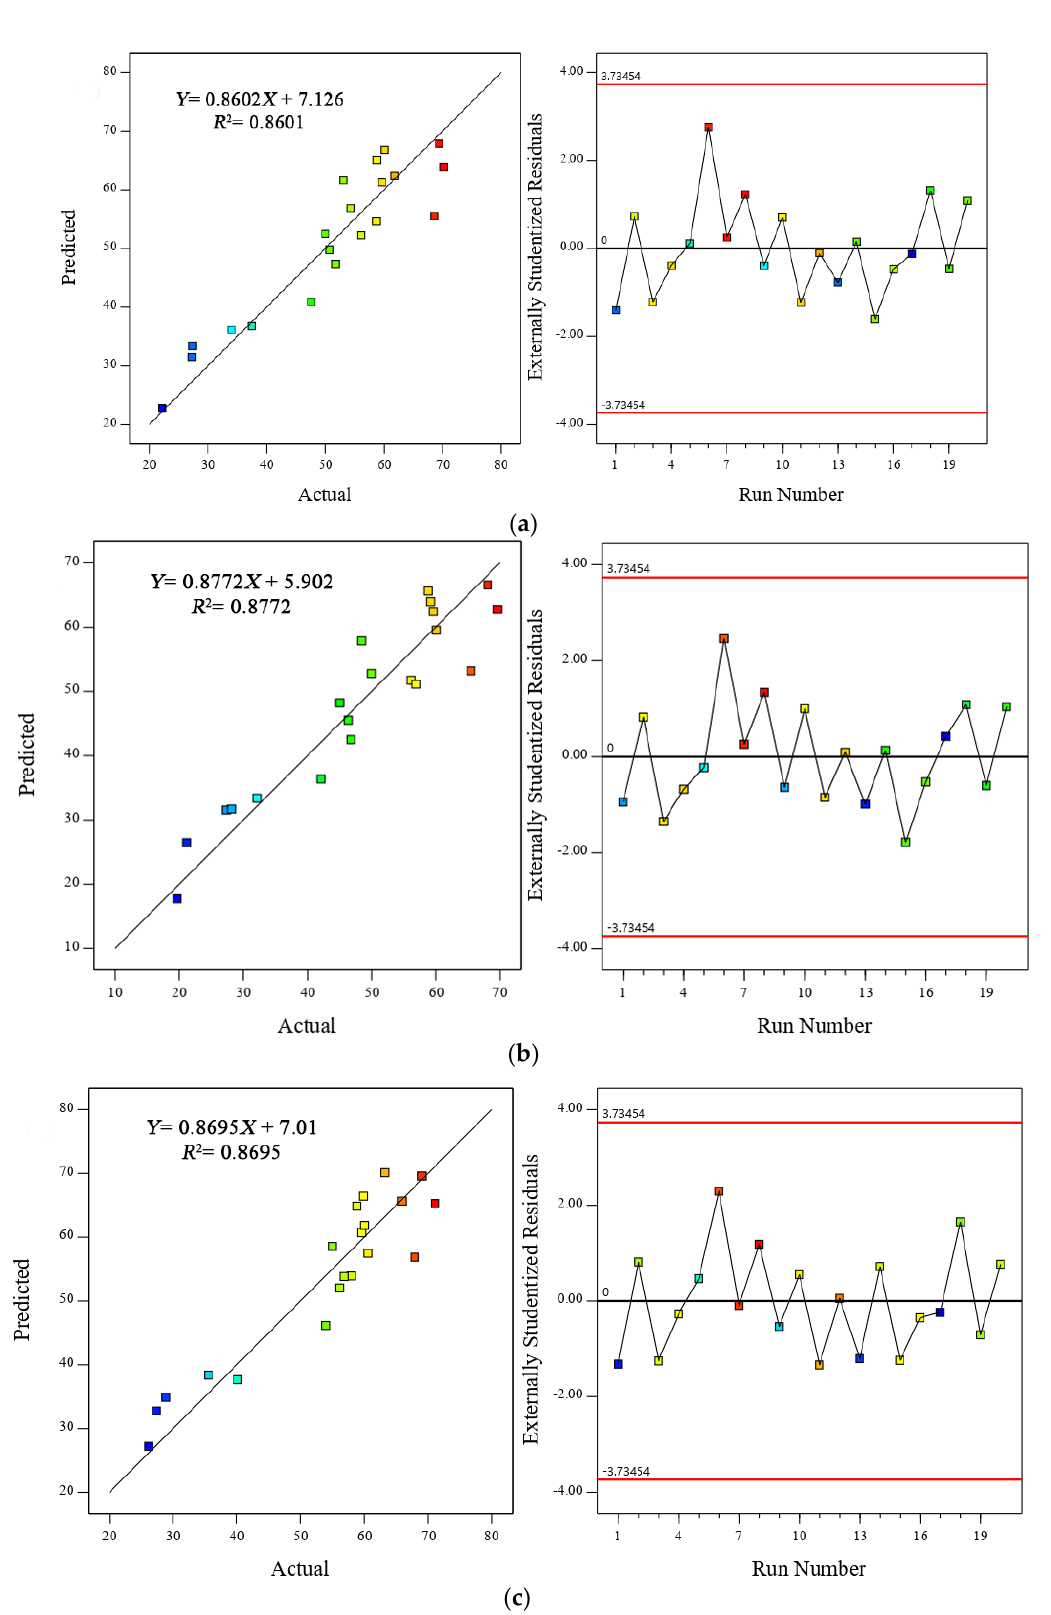
Figure 3. Correlation between the predicted and actual values of the compressive strength for ( a ) Model 1, ( b ) Model 2, and ( c ) Model 3.